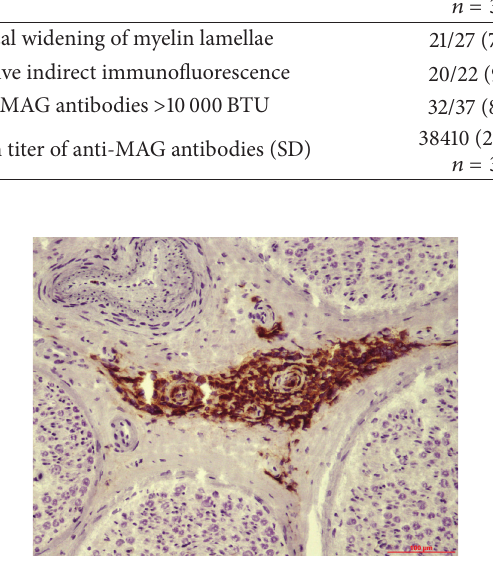
Figure 3: Several epineurial vessels are surrounded by prominent B cell infiltrates (patient 26). Paraffin transverse section labelled with anti-CD20 antibody.